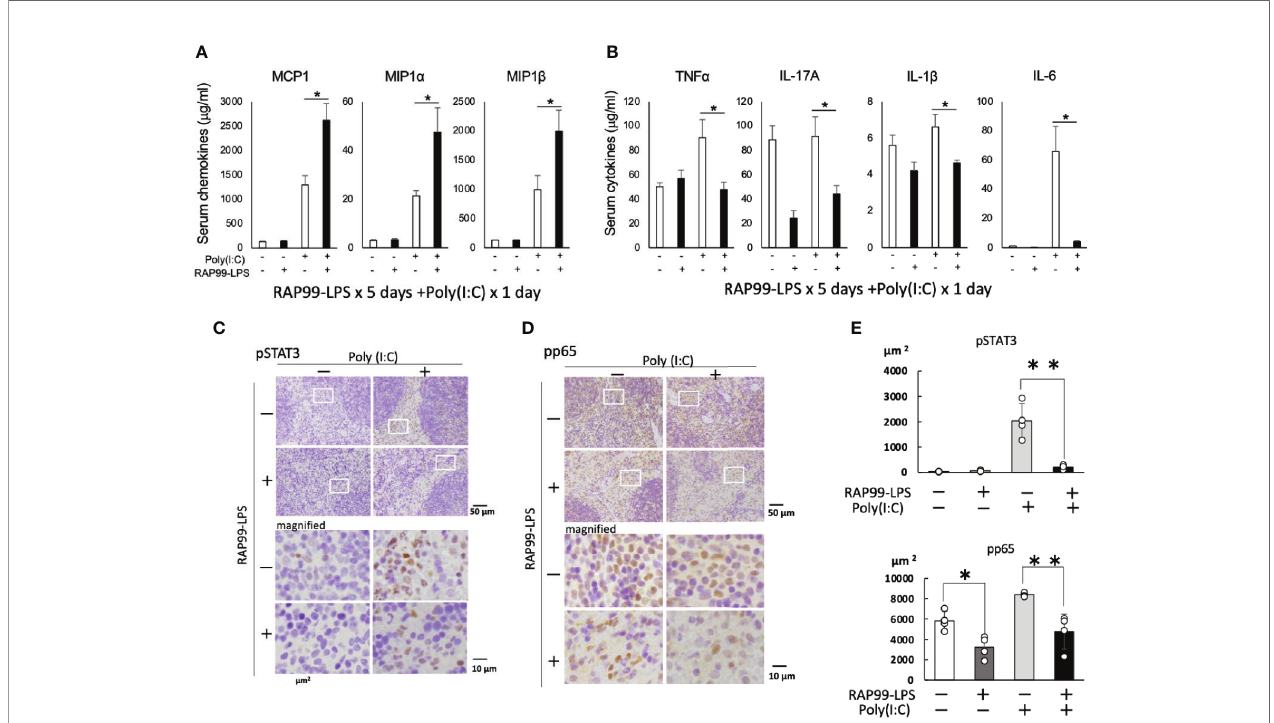
FIGURE 7 | RAP99-LPS pretreatment enhanced the expression of chemokines and suppressed the expression of NF-kB- and STAT3-stimulating cytokines after TLR3 ligand injection. RAP99-LPS (200 m g/day) or saline was intraperitoneally injected into C57BL/6 mice every day 5 times followed by the injection of poly(I:C) (200 m g) on day 6. Serum chemokine (A) and cytokine (B) levels were investigated 6 h later. Mean scores ± SD are shown. *p < 0.05; Student ’ s t tests. Immunohistochemistry of spleens was performed with anti-phospho-STAT3 antibody (C) and anti-phospho-NF-kB antibody (D) . (E) Quanti fi ed data of (C) and (D) . The area ratio of nuclei with pStat3 or pp65 (DAB + area) is presented per 10,000 m m 2 (Hematoxylin + area). (n = 4 each; Representative data are shown.) *p < 0.05, **p <